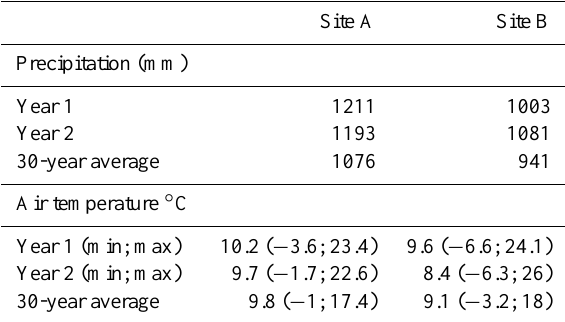
Table 1. Selected climatic data from two research locations during Year 1 (April 2011 to March 2012) and Year 2 (April 2012 to March 2013) and compared with the 30-year average (1981–2010) (Met Eireann,